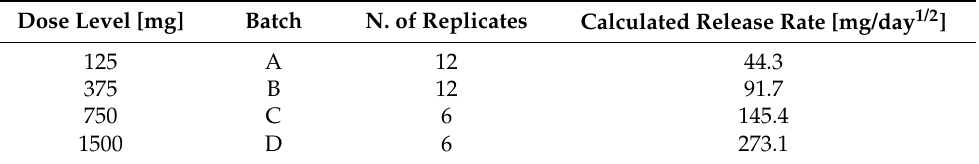
Table 1. Analyzed in vitro release